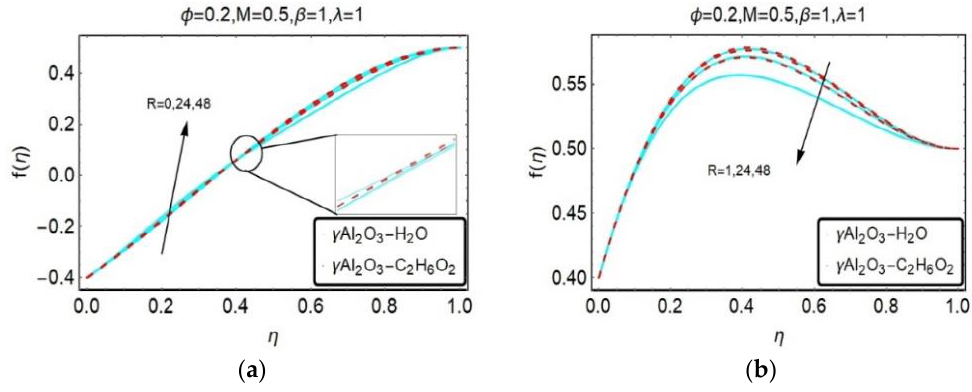
Figure 2. Influence of 𝑅 on 𝑓(𝜂) for ( a ) 𝑆 > 0 and ( b ) 𝑆 < 0 .